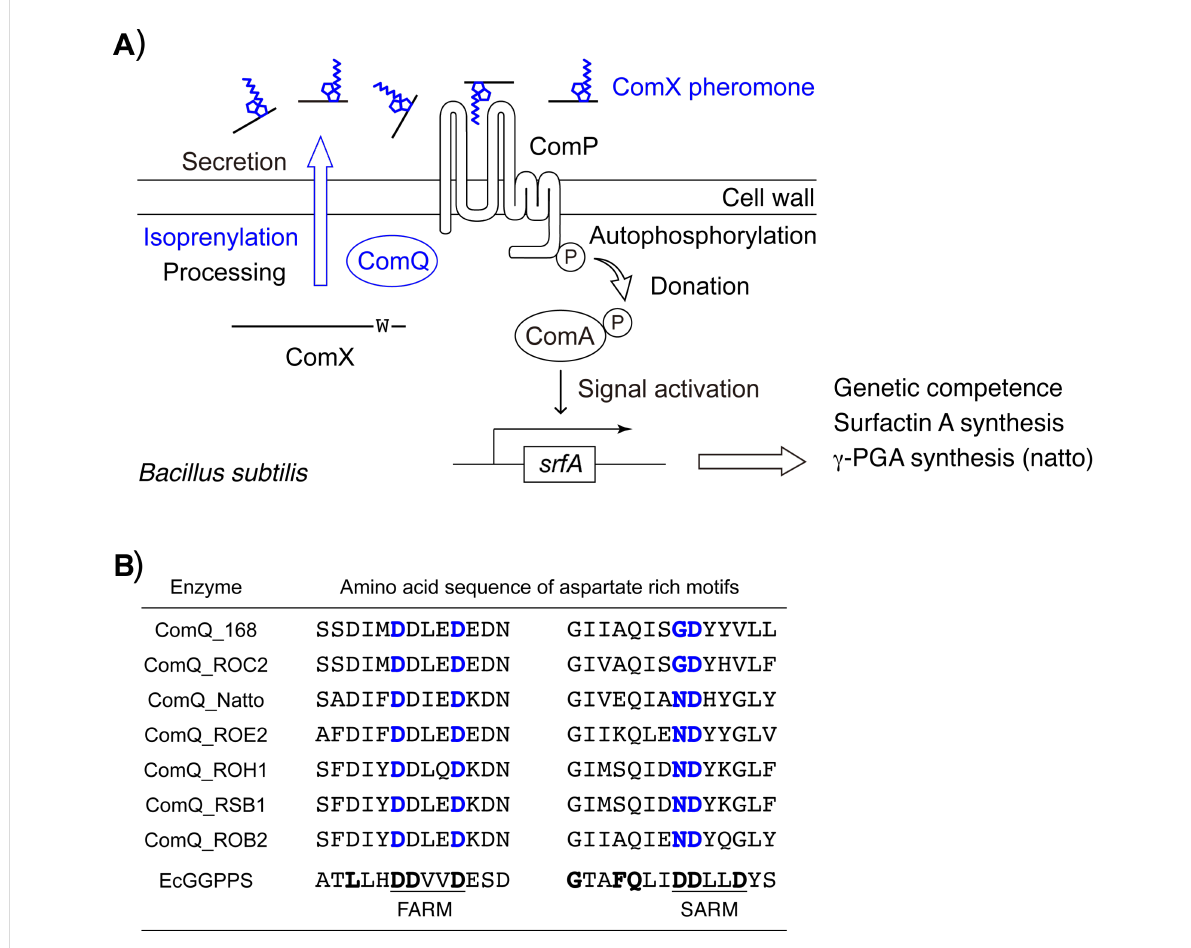
Figure 4: (A) Schematic representation of the signal transduction cascade of quorum sensing stimulated by the ComX pheromone in B. subtilis . (B) Amino acid sequences of the aspartate-rich motif and the pseudo aspartate-rich motif in ComQ from seven Bacillus strains. Essential amino acid residues for function are shown in bold and colored blue. EcGGPPS is a geranylgeranyl diphosphate synthase derived from Escherichia coli ISC56. It’s essential amino acid residues for function are shown in boldface, and the aspartate-rich motifs are